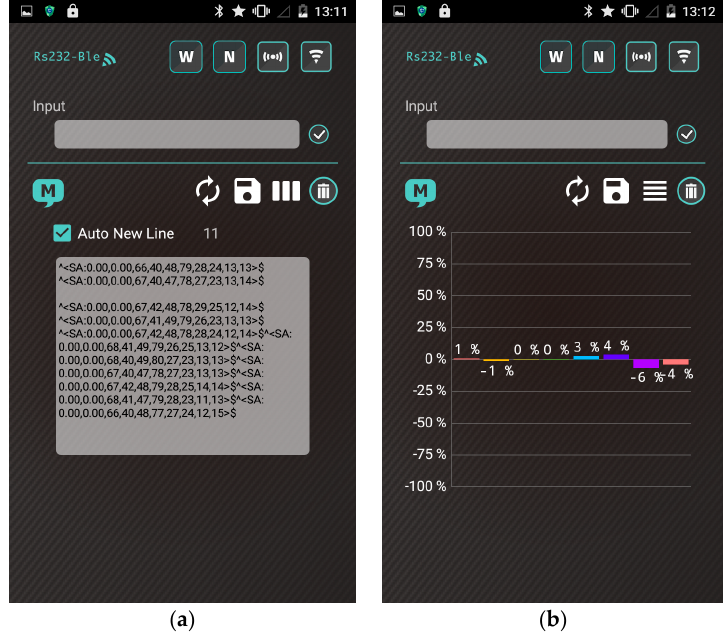
Figure 7. Smartphone application developed for wearable and wireless gas-sensing system. ( a ) The stream of sensor data; ( b ) Bar chart graph.